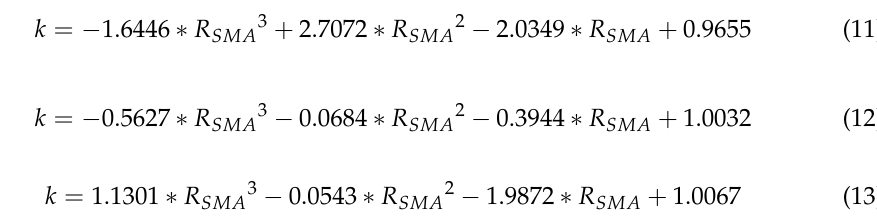
Figure 3. Comparison of models of stiffness sensing characteristics at different currents.